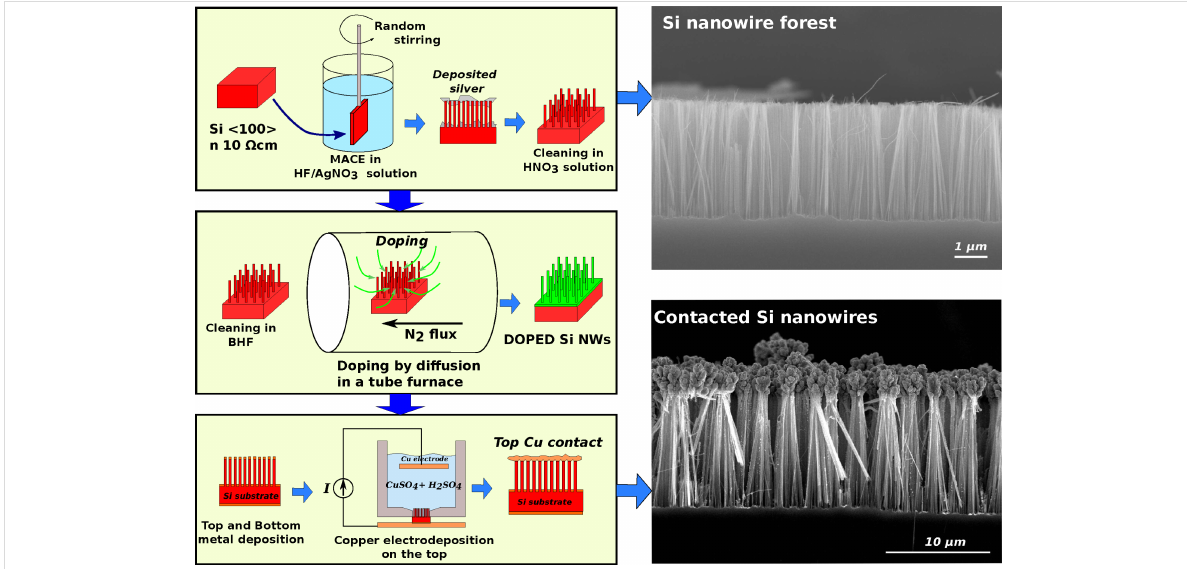
strate, that is, so-called silicon nanowire (SiNW) forests. The process is very suitable for the large-scale fabrication of nano- structured devices useful for several applications, such as sensing, photovoltaics, energy storage (supercapacitors), and, in particular, thermoelectric applications [15-17]. There are two main requirements to the fabrication of a leg for a thermo- electric generator that is based on a large number of silicon nanowires perpendicular to a substrate: 1) Electrical contacts need to fabricated on the top of a silicon nanowire forest, which can be achieved by copper electrodeposition [18]. 2) The optimum doping concentration of the nanowires for the exploitation of the maximum power factor of silicon [3] needs to be found. Both the Seebeck coefficient and the electrical conductivity depend on the doping concentration. In particular, S decreases with increasing doping concentrations. At the same time, high doping concentrations yield high values of electrical conductivity σ . Hence, a trade-off between S and σ needs to be found, such that the product S 2 σ is maximized. Nanowires with an average diameter of 80 nm and a length of several hundreds of micrometers can easily be obtained from MACE on n- and p-doped substrates, with concentrations up to 10 18 cm − 3 . How- ever, the maximum of the power factor is achieved for doping concentrations greater than 10 19 cm − 3 [2,3]. Unfortunately MACE yields very unreliable results at such high doping con- centrations. In the case of p + doping, parameters for a satisfac- tory fabrication of monocrystalline SiNW forests have been found [17]. However, the reliable fabrication of n + SiNWs by MACE is still an open issue [19,20]. Hence, it is currently not possible to fabricate an optimized generator module based on two legs with opposite heavy